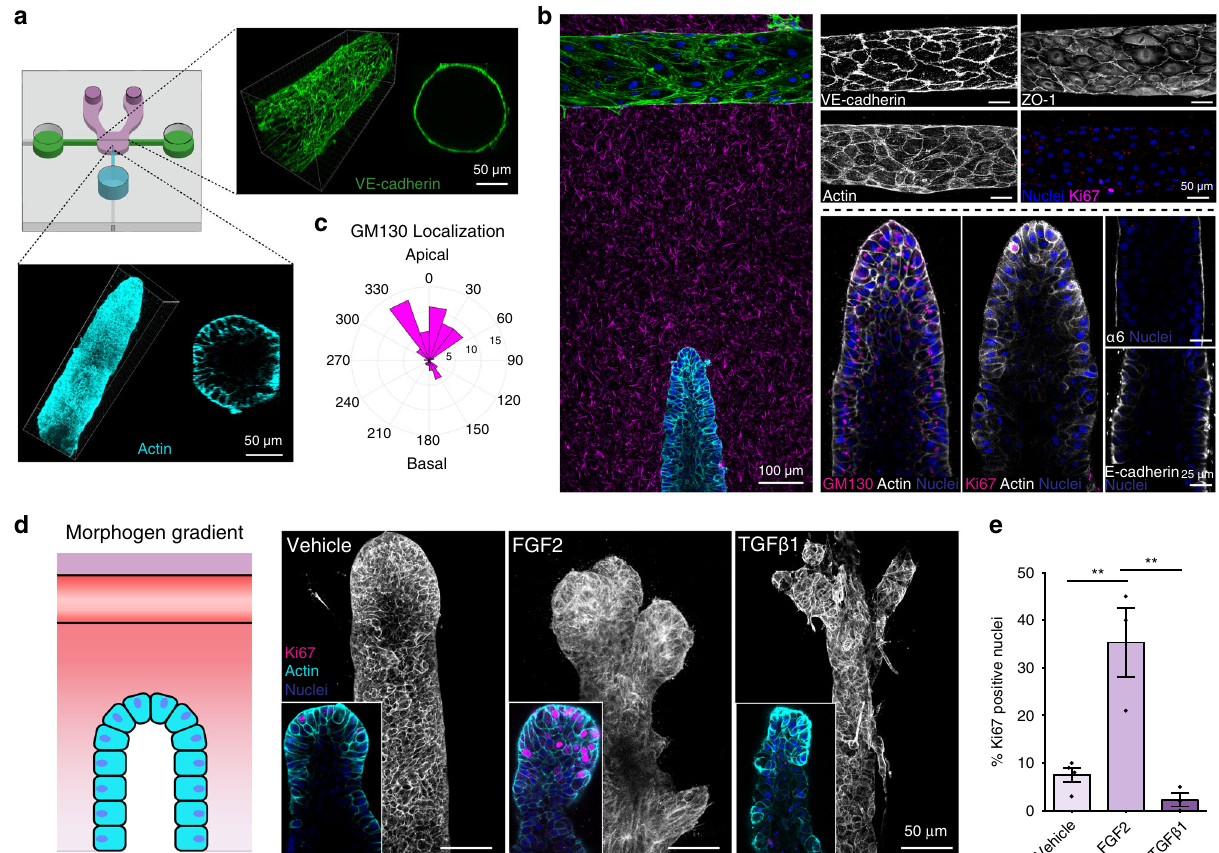
Fig. 1 A vascularized mammary duct platform models native 3D tissue architectures and morphogenesis. Tissues are at one week of co-culture unless otherwise indicated. a Organotypic micro fl uidic device consisting of an engineered 3D endothelial vessel (green) and mammary epithelial duct (cyan) in physiologic ECM (magenta), enabling long-term culture and paracrine signaling. Inset: 3D reconstruction of endothelial vessel (green — VE-cadherin) and epithelial duct (cyan — phalloidin). b Left: Composite stitched maximum intensity projection micrograph of tissue base to medial section of a mammary epithelial duct (cyan, phalloidin) and proximal vasculature (green, phalloidin); Alexa Fluor-labeled collagen I (magenta), DAPI (blue). Top right: Representative maximum intensity micrographs of mature endothelial vessels immunostained for VE-cadherin, ZO-1, actin, and Ki67, as indicated. Bottom right: Individual confocal slice micrographs from 3D epithelial duct midsections immunostained for GM130, Ki67, α 6 integrin, E-cadherin, actin, and DAPI, as is indicated in each panel. c Quanti fi cation of golgi localization as measured by the nuclear-GM130 axis ( n = 52 cells examined from three independent ducts). 0 corresponds to a nuclear-GM130 axis apically oriented toward the lumen, while 180 corresponds to a basal orientation. d Cartoon depicting morphogen gradients established by perfusing growth factors through an acellular vascular channel. Immunographs of quiescent MCF10A ducts exposed to vehicle (DMSO), FGF2 (3 nM), or TGF β 1 (5 ng/ml) gradients for three days. Inset: high magni fi cation slice micrograph of duct terminus immunostained with phalloidin (cyan), DAPI (blue) and Ki67 (magenta). e Quanti fi cation of percentage of Ki67 positive nuclei in ducts treated with each morphogen gradient ( n = 4, 3, 3 ducts examined across three independent experiments; one-way ANOVA with Bonferroni post test Vehicle vs FGF2 ** p = 0.0036, FGF2 vs TGF β 1 ** p = 0.002, mean ± s.e.m). All images are representative of at least three independent experiments. Source Data are provided as a Source Data fi